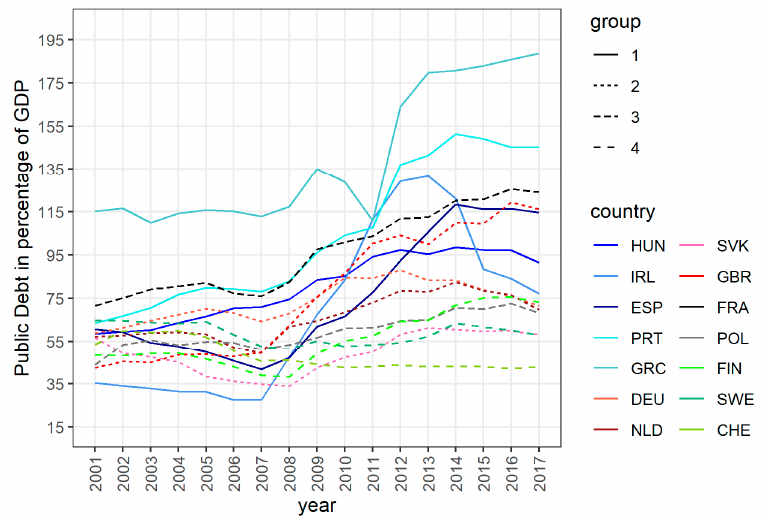
Figure 2. The development of public debt in analyzed countries.